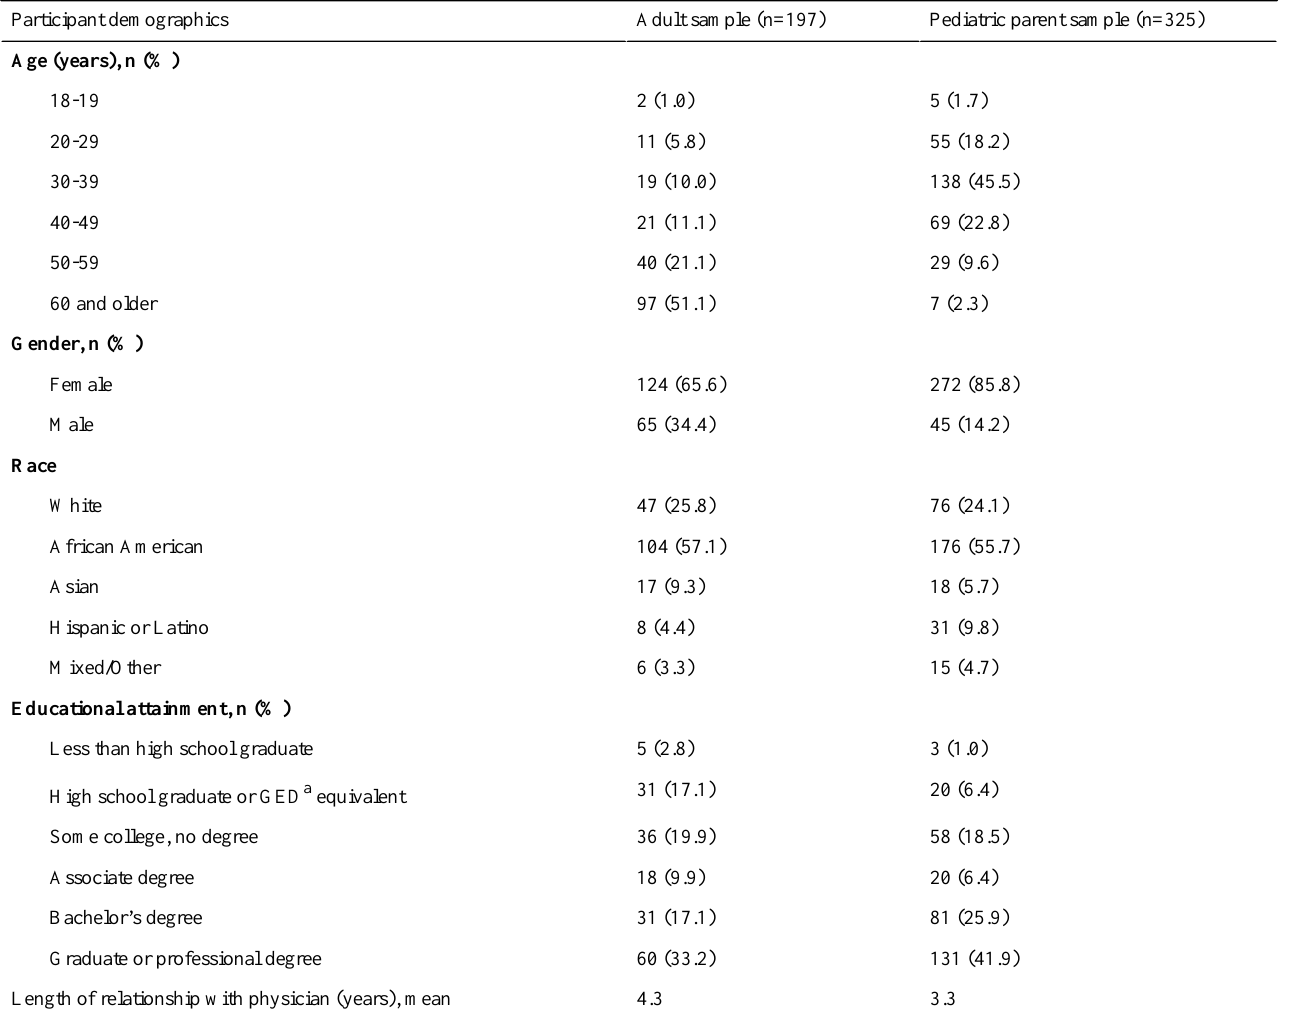
Table 2. Participant